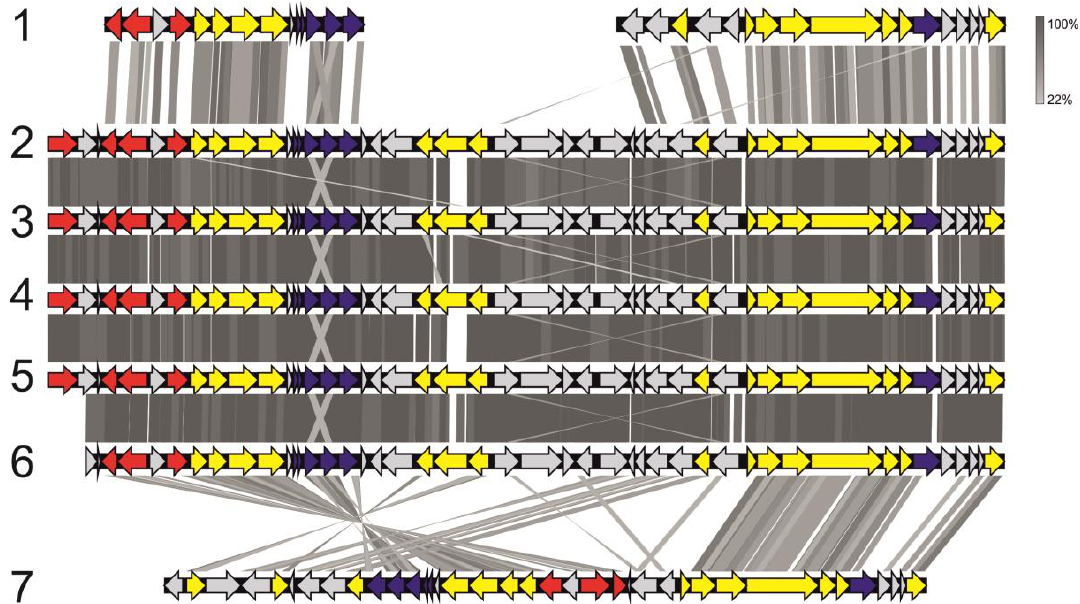
Figure 7. Organization of gene clusters associated with phototrophy in the genomes of Methylocystis species in comparison to that in the genomes of the phylogenetically-related methylo- and methanotrophs. The picture shows: Methylobacterium phyllosphaerae CBMB27 (1), Mc. rosea BRCS1 (2), Mc. rosea GW6 (3), Mc. rosea SV97 T (4) Methylocystis sp. Mitz-2018 (5), Methylocystis sp. SB2 (6) and Methylocapsa palsarum NE2 T (7). Grey strips reflect the identity level of homologous proteins (see color code). Genes encoding photosystem II, carotenoid biosynthesis, and bacteriochlorophyll synthesis are shown in dark purple, red, and yellow, respectively. Other genes are shown in light grey.